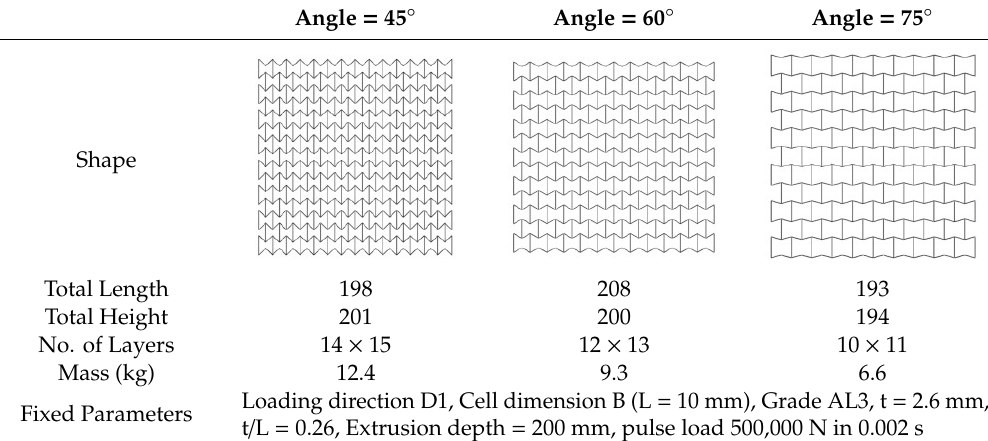
Table 6. Auxetic cores with three different cell angles and their properties.